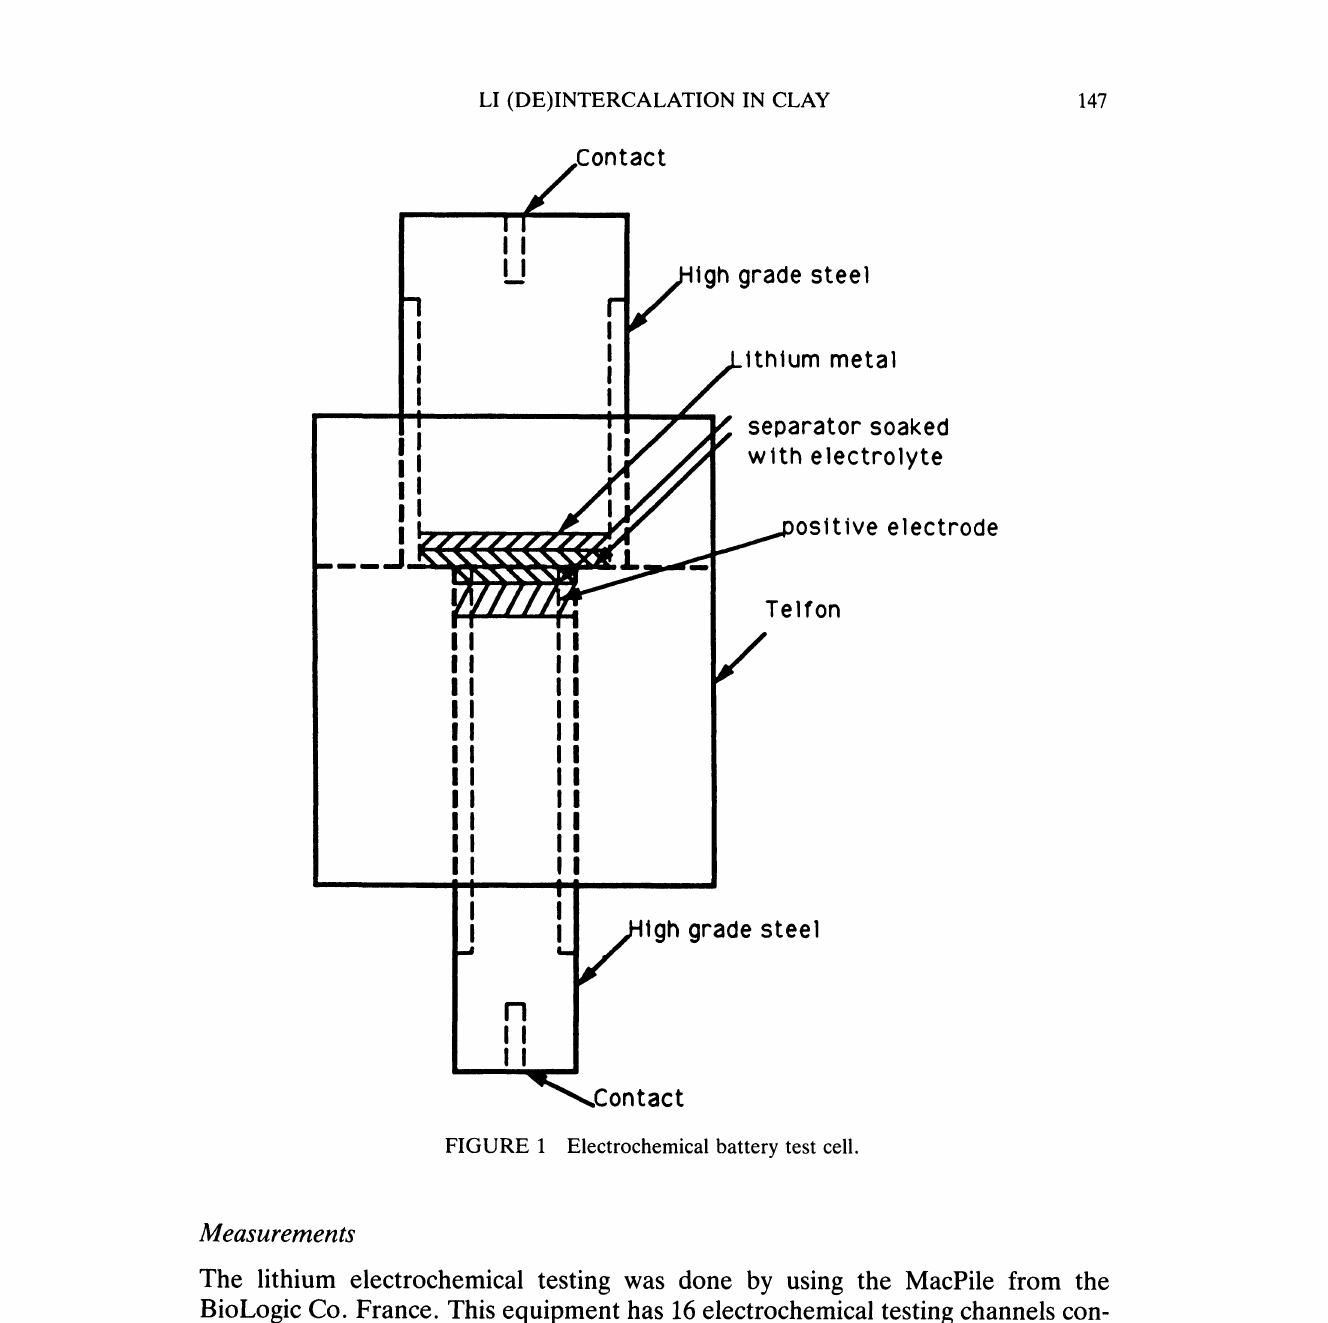
FIGURE Electrochemical battery test